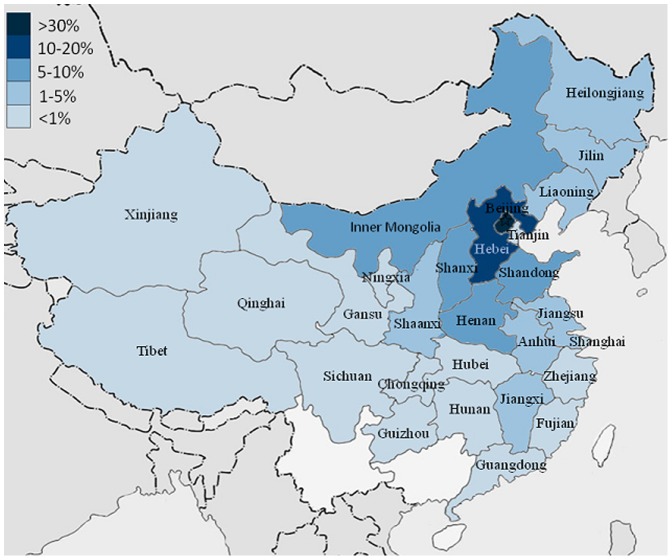
Regional distribution of headache patients in the current study (n = 1843).Patients came from 28 regions of China. Colors from dark to light indicate different proportion of headache patients from higher to lower (5 levels: >30%, 10–20%, 5–10%, 1–5%, and <1%).